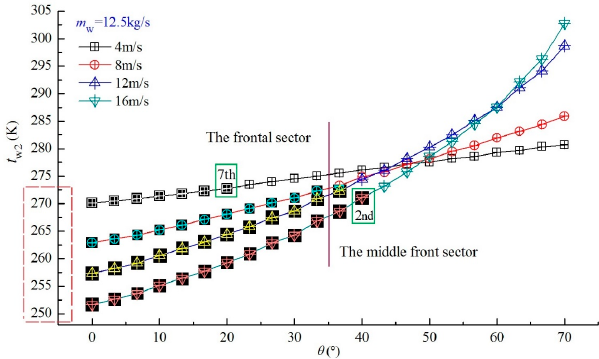
Figure 7. Outlet water temperature of each delta in frontal and middle front sectors with original flow rate of circulating water.